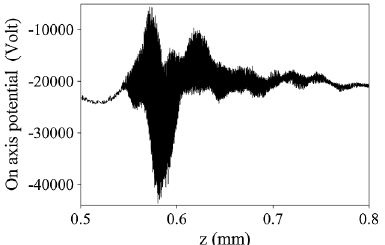
FIG. 10. Detail of the potential curve (from Fig. 9) after 17.5 ps in the longitudinal direction. The plasma oscillation has a higher potential fluctuation at lower z positions, where the simulated particle density is higher.